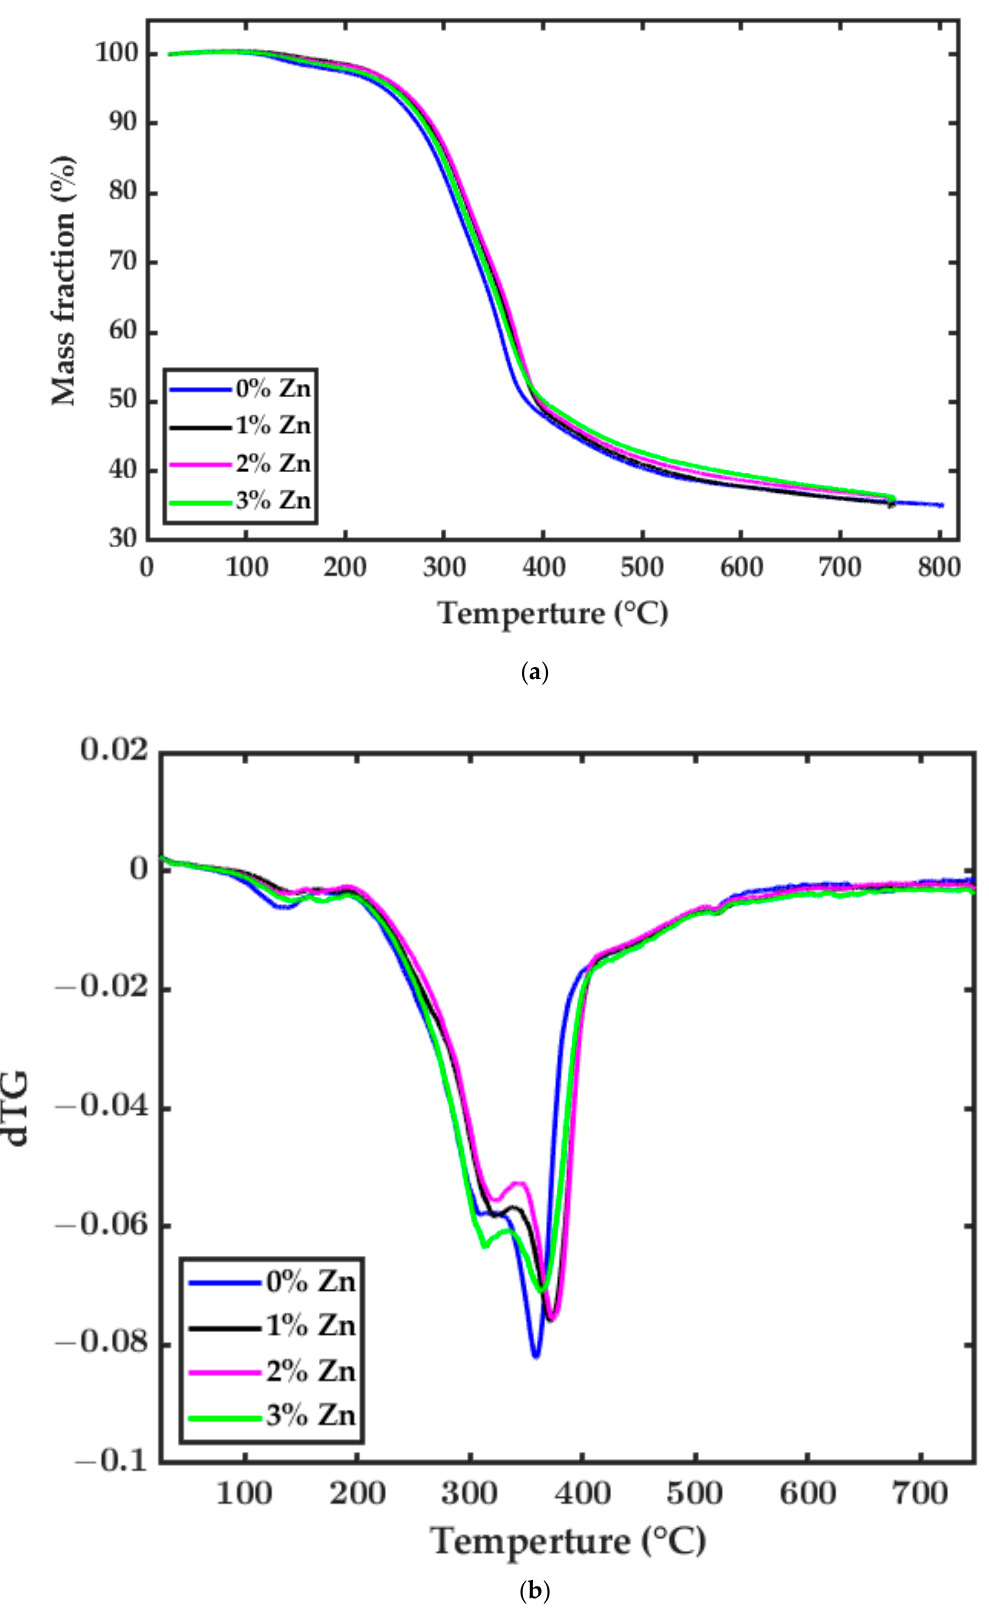
Figure 2. EFB at 30 K/min heating rate: ( a ) Mass loss curve for samples with 0%, 1%, 2%, and 3% catalyst. ( b ) DTG curves for samples with 0%, 1%, 2%, and 3% catalyst.